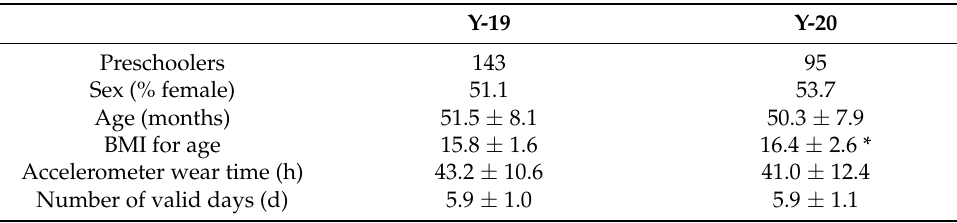
Table 2. Characteristics of preschoolers in the sample.